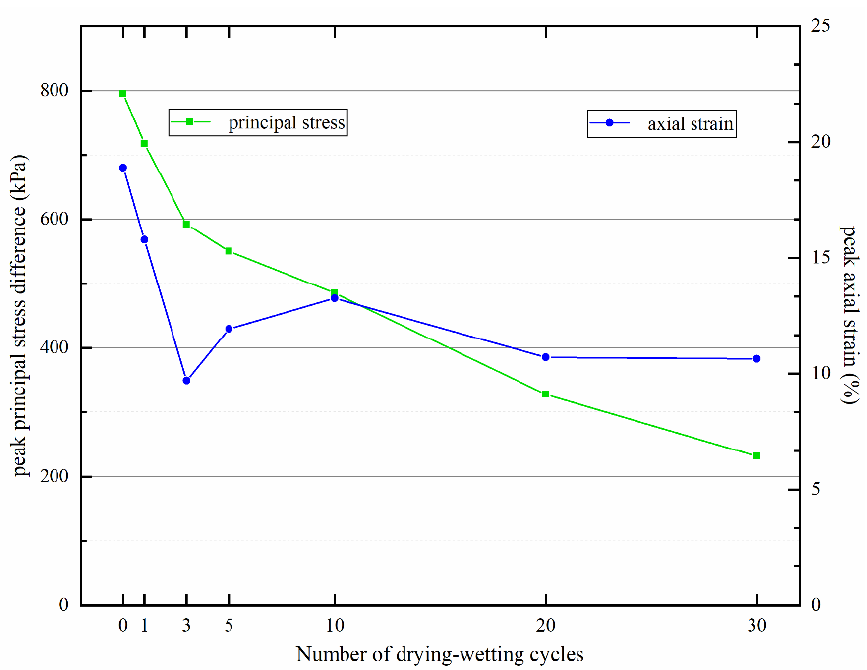
Figure 6. Variations of characteristic parameters of stress–strain curves with the number of drying– wetting cycles.